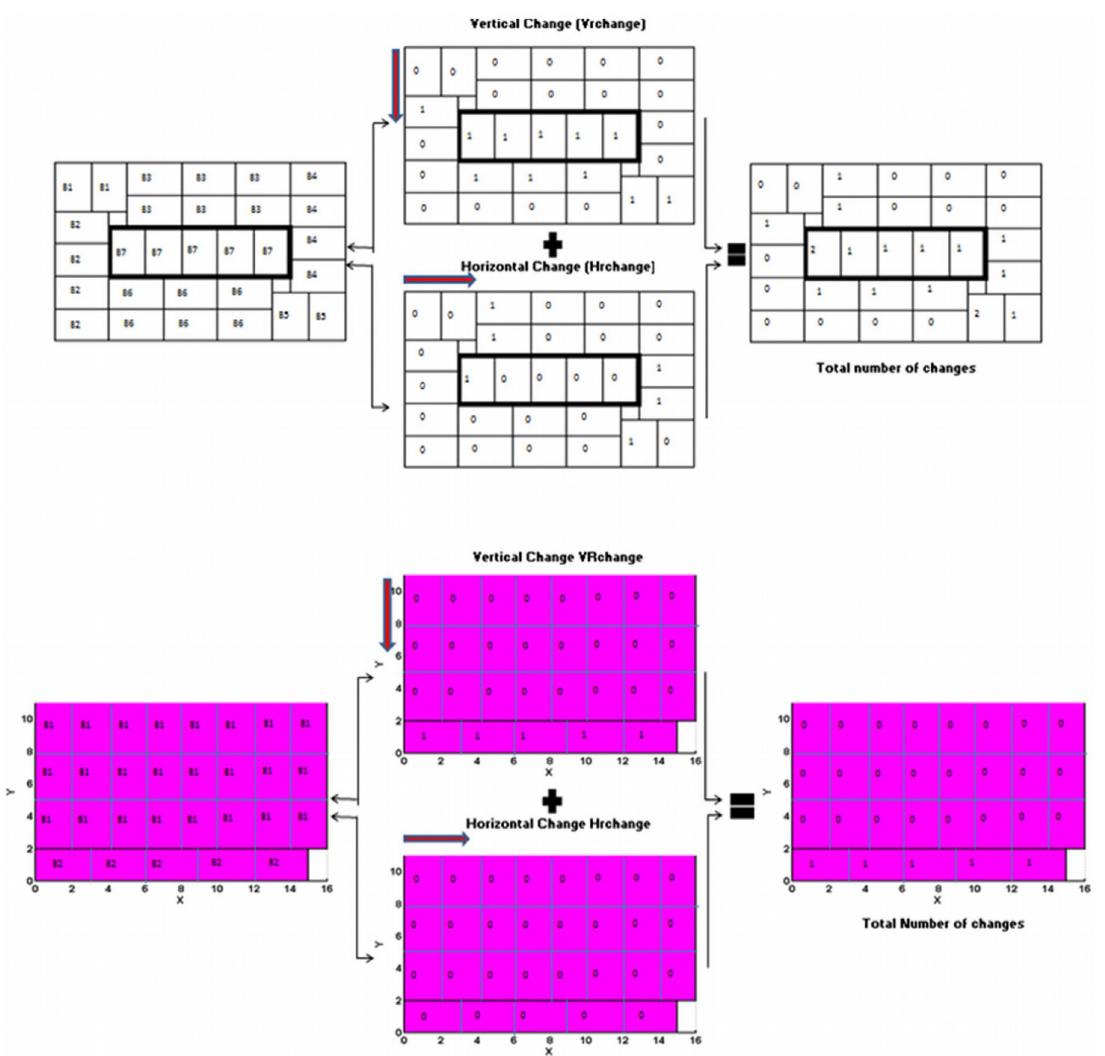
Figure 6. Complexity Index Calculation method for Instance 4